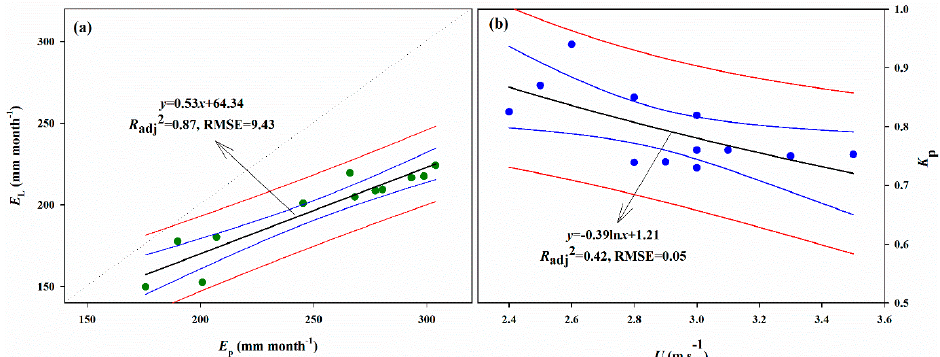
Figure 7. Relationship between ( a ) measured monthly lake evaporation ( E L , mm·month − 1 ) and observed pan evaporation ( E p , mm·month − 1 ) and ( b ) pan coefficient ( K p = E p / E L ) and wind speed ( U , m·s − 1 ) during the unfrozen period in 2014 and 2015. The data can be found in Table 2. The linear fitting, 95% confidence band, prediction band line, and value of regression analysis are shown.